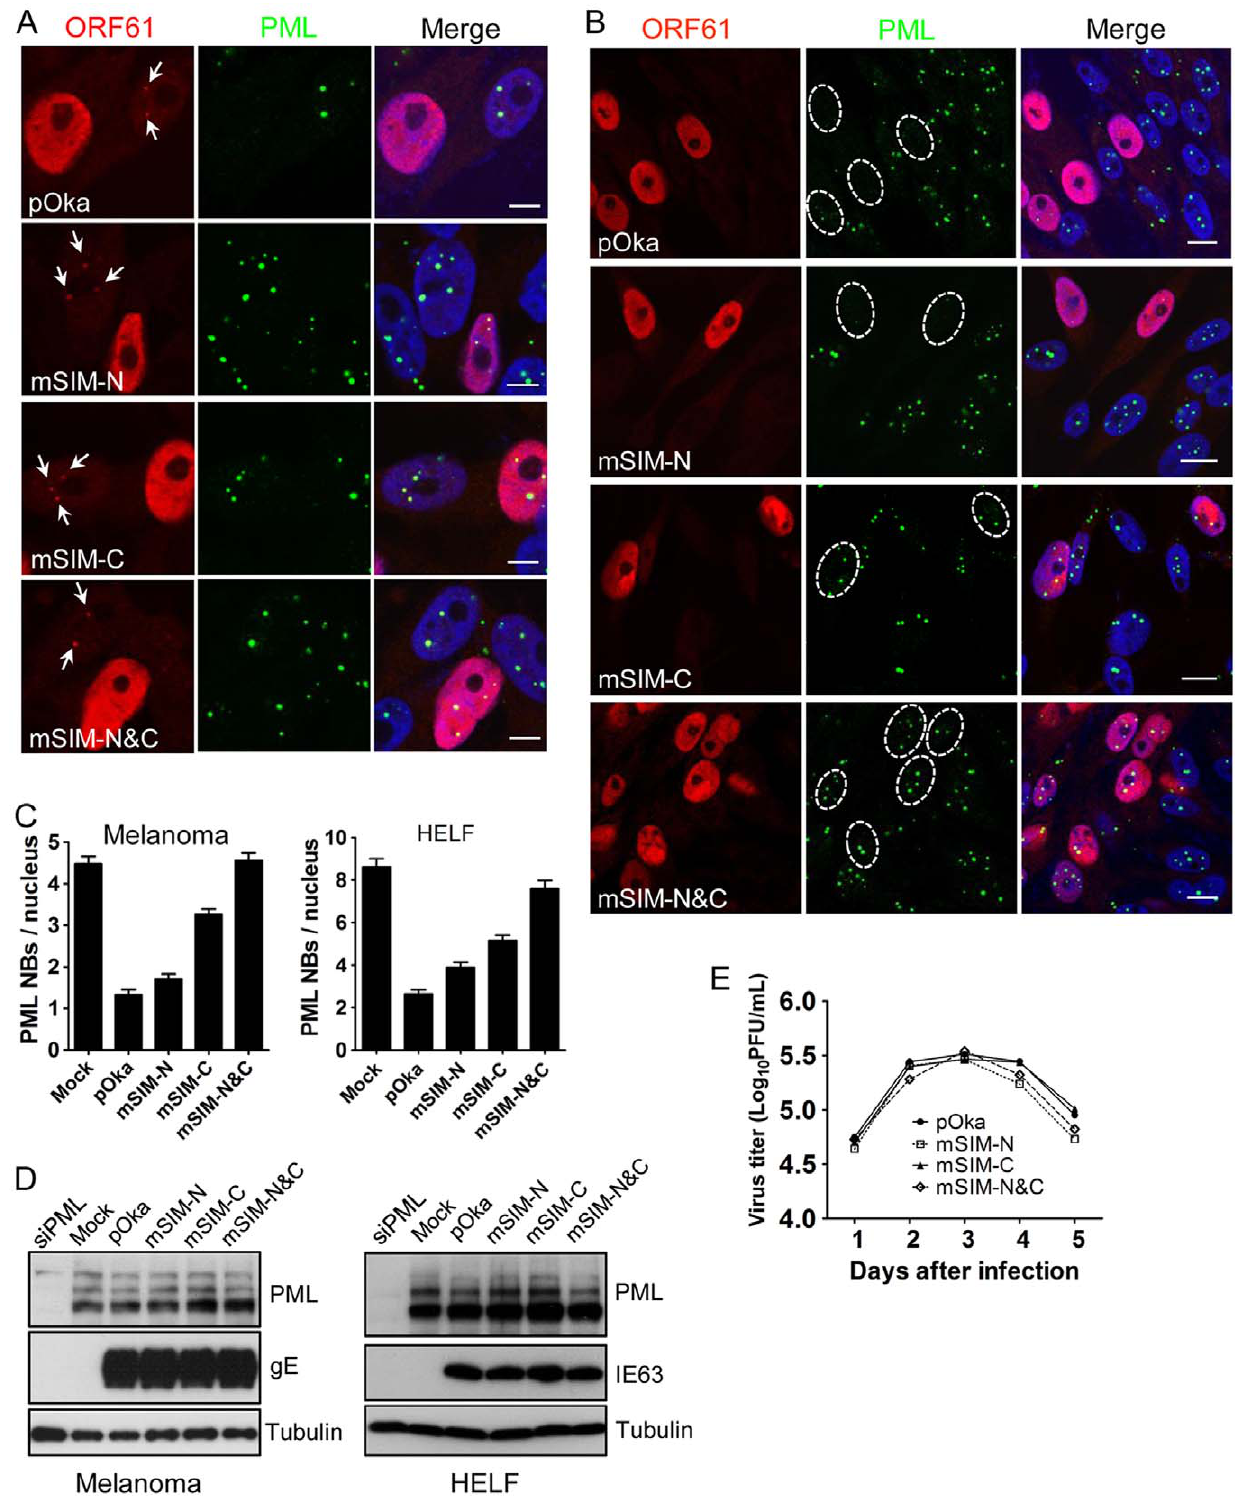
Figure 5. ORF61 SIMs are essential for PML NB disruption in VZV-infected cells but not required for VZV replication invitro . (A) Confocal microscopy of melanoma cells that were infected with pOka and ORF61 SIM mutants for 6 h and stained for ORF61 (red), PML (green), and nuclei (blue). The images show association of puncta (indicated by white arrows) formed by ORF61 and SIM mutant proteins with PML NBs. Scale bars: 5 m m. (B) Confocal microscopy of melanoma cells that were infected with pOka and ORF61 SIM mutants for 24 h and stained for ORF61 (red), PML (green), and nuclei (blue). The images show PML NB dispersal in pOka- or SIM mutant-infected cells. Infected nuclei with abundant expression of ORF61 or SIM mutant proteins are outlined by dashed ovals. Scale bars: 10 m m. (C) PML NB frequencies (mean 6 SEM) in pOka/ORF61 SIM mutants- infected melanoma cells (Mock, N=213; pOka, N=206; mSIM-N, N=212; mSIM-C, N=202; mSIM-N&C, N=232) and HELFs (Mock, N=227; pOka,